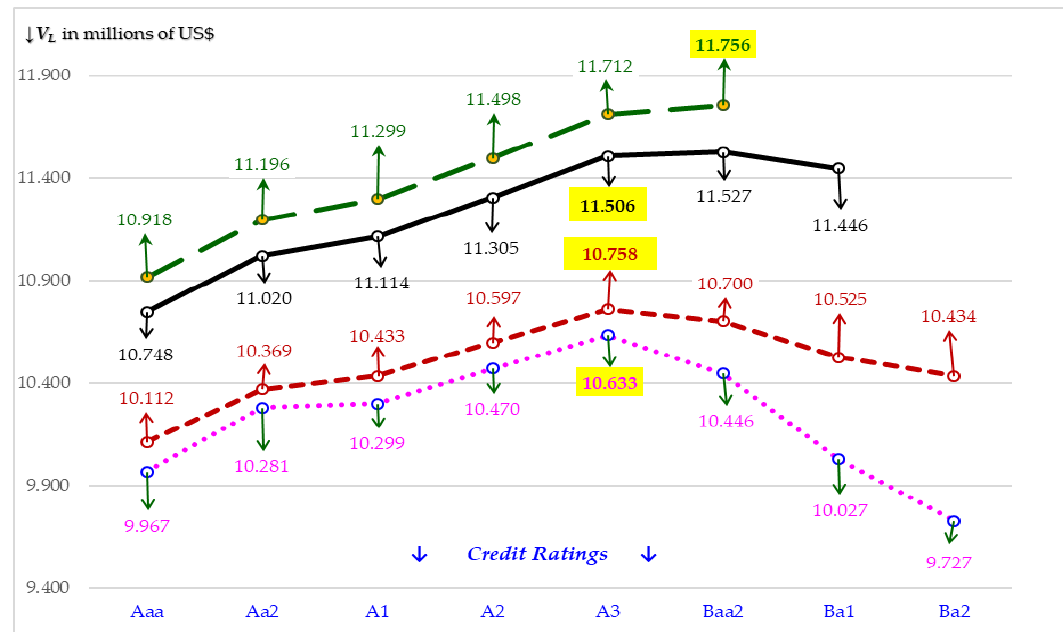
Figure 3. Nongrowth firm value ( V L ) (dotted line), 3.12% Growth V L (smaller dashed line), 3.90% Growth V L (solid line), and 4.50% Growth V L (larger dashed line) Versus Moody’s Credit Ratings for Pass-Throughs under TCJA with OCR of A3 target except for top trajectory where OCR is Baa2.